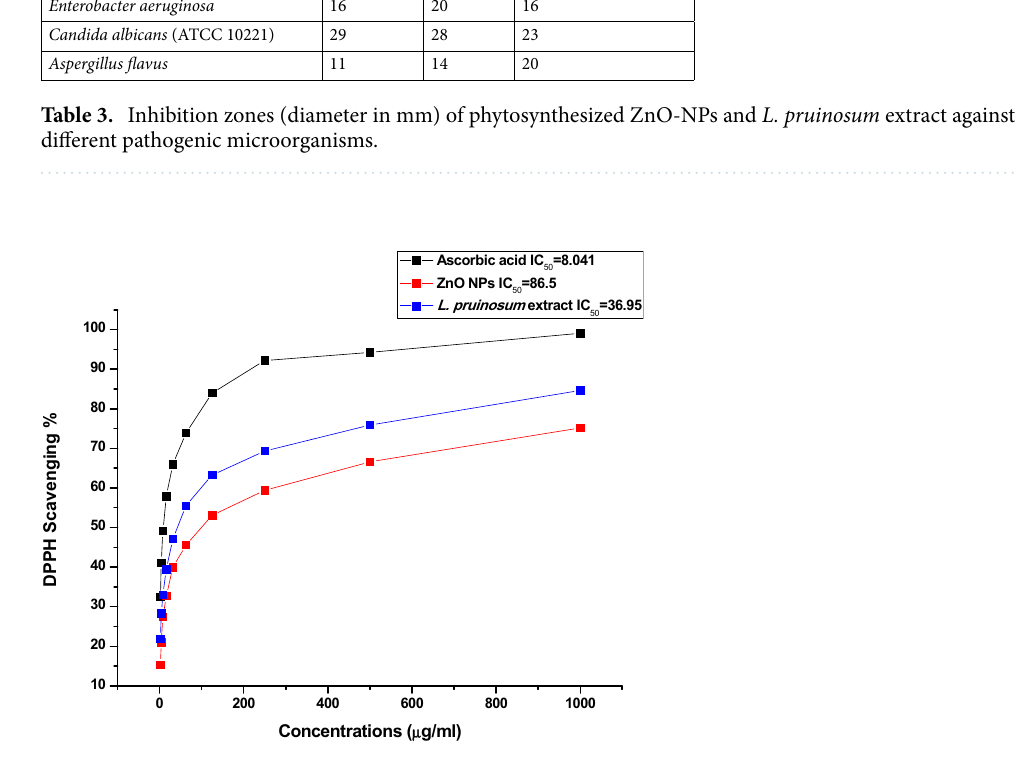
Figure 6. Antioxidant activity of ZnO NPs, L. pruinosum extract and Ascorbic